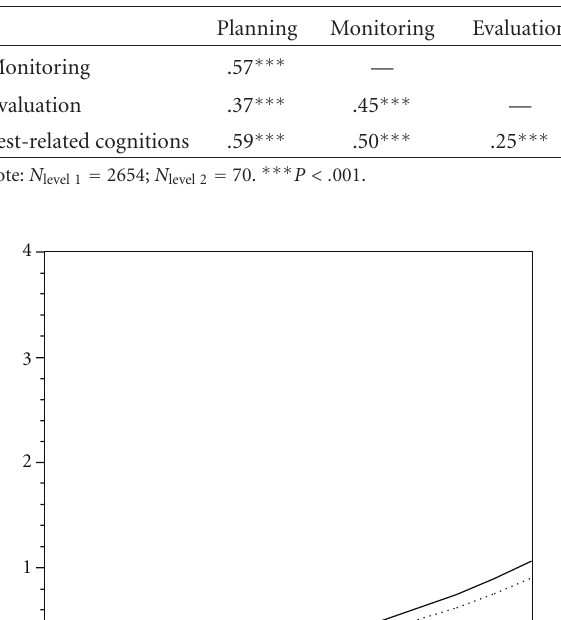
Table 3: Correlations between test-related cognitions and metacog- nitive strategies.